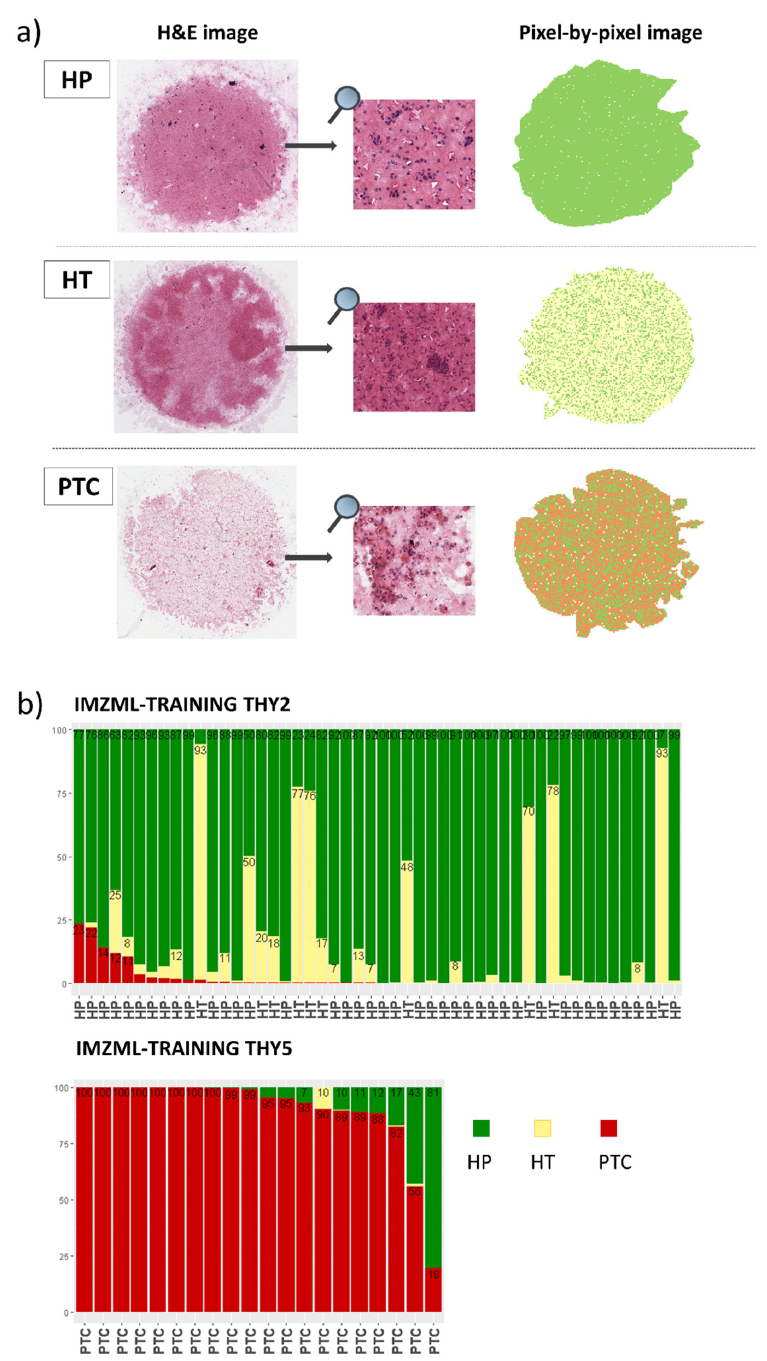
Figure 1. Results of the pixel ‐ by ‐ pixel (IMZML) classification of the training set samples. ( a ) Examples of H&E and pixel ‐ by ‐ pixel images of hyperplastic (HP), Hashimoto’s thyroiditis (HT), and papillary thyroid cancer (PTC) samples; ( b ) stacked bar charts of the percentage of pixels in each FNA of the training set classified as HP (green), HT (yellow), and PTC (red) in the 50 TIR2/THY2 and 20 TIR5/THY5 samples. Each FNA was classified as malignant when the percentage of red pixels was >7%.